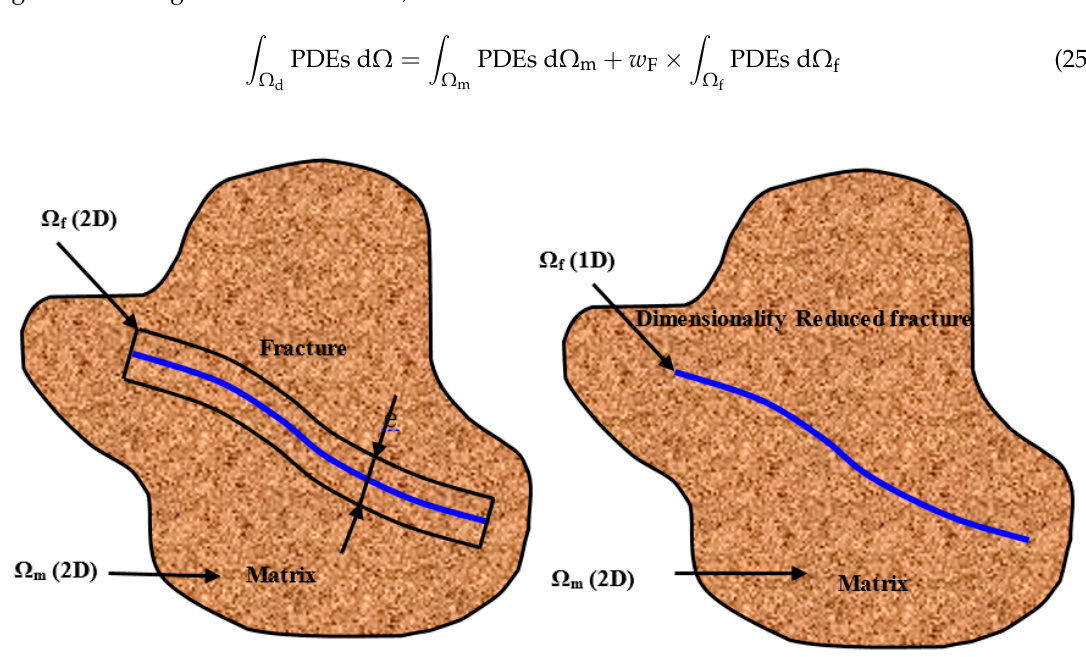
Figure 8. Concise description of the discrete fracture model network (DFN) model.